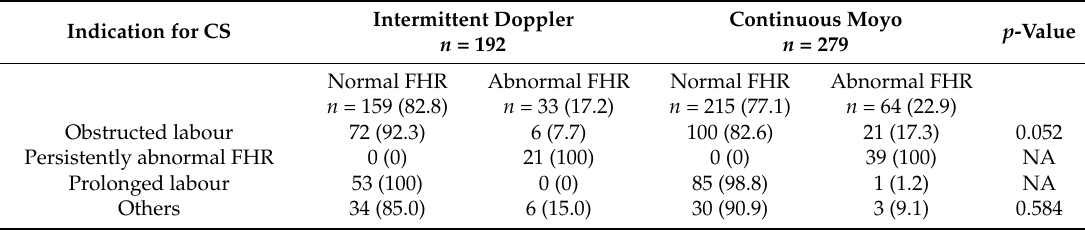
Table 4. Comparison of indications for Caesarean section (CS) by foetal heart rate (FHR) abnormalities between Doppler and